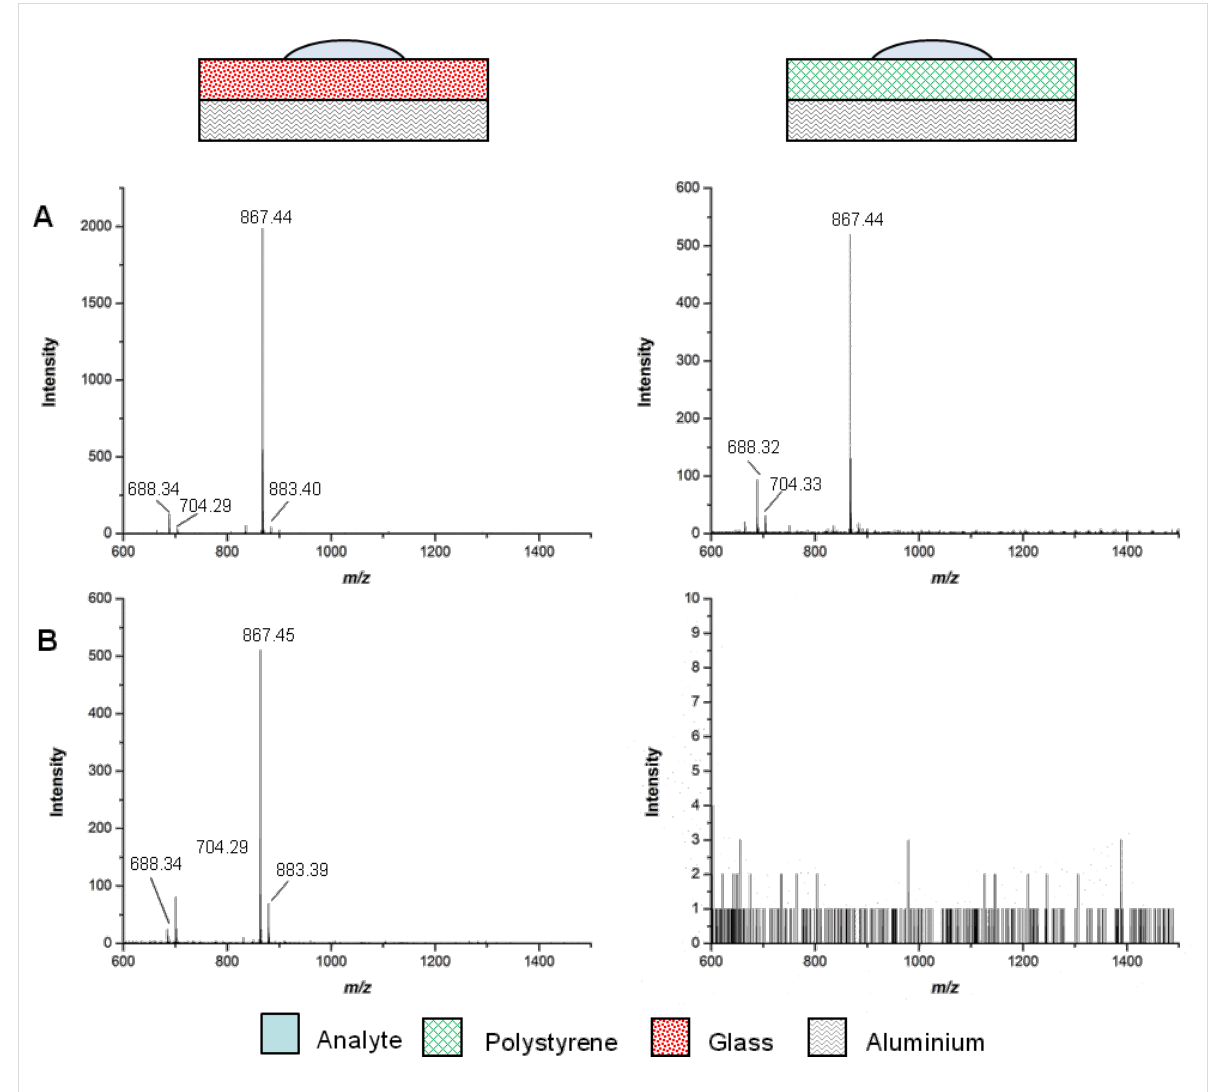
Figure 4: Comparison of MALDI-TOF MS spectra on the aluminium-backed polystyrene and glass slides after washing. ( A ) At 7.5 nmol following washing procedure 1 and ( B ) at 15 nmol following washing procedure